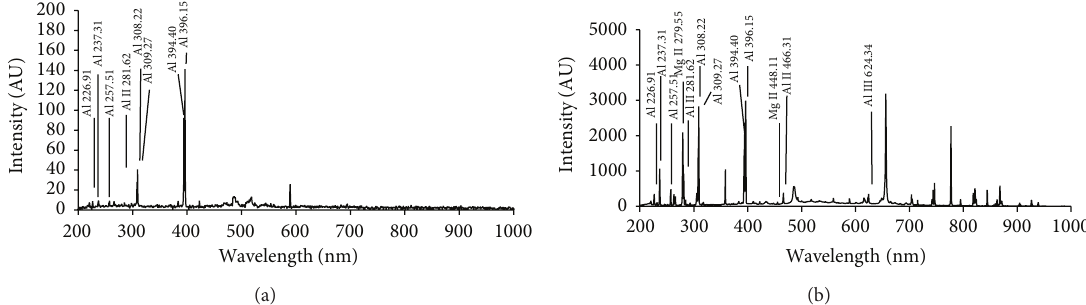
Figure11:(a)LIBSsignalfromceramicaluminatargetforNd:YAGlaserinitiatedplasma.(b)LIBSemissionsignalforaNd:YAGlaserinitiated plasma and CO 2 laser enhancement.